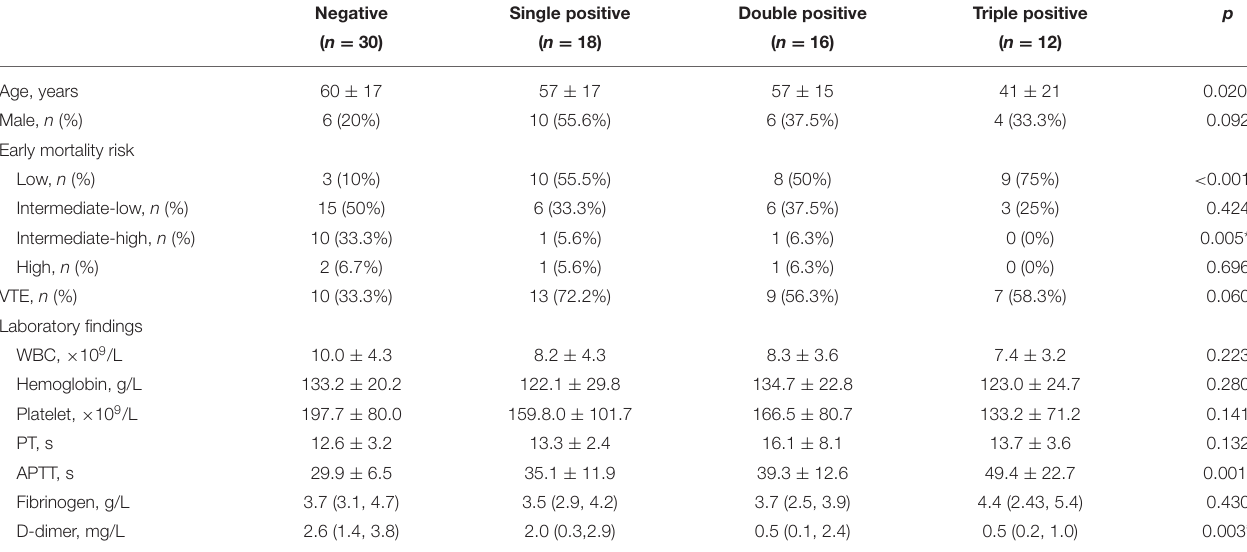
TABLE 4 | Comparison of clinical characteristics within positive antibody